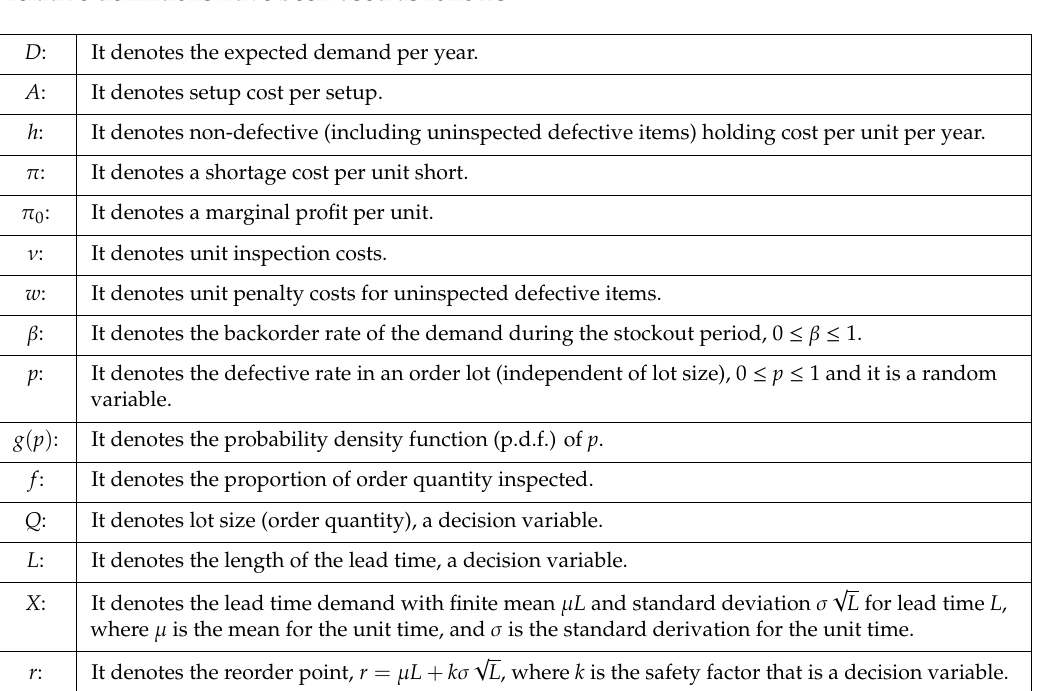
Table 1. A comparison for the inventory models by the literature review. TheUninspected Inspecting Defective Cost Penalty Cost